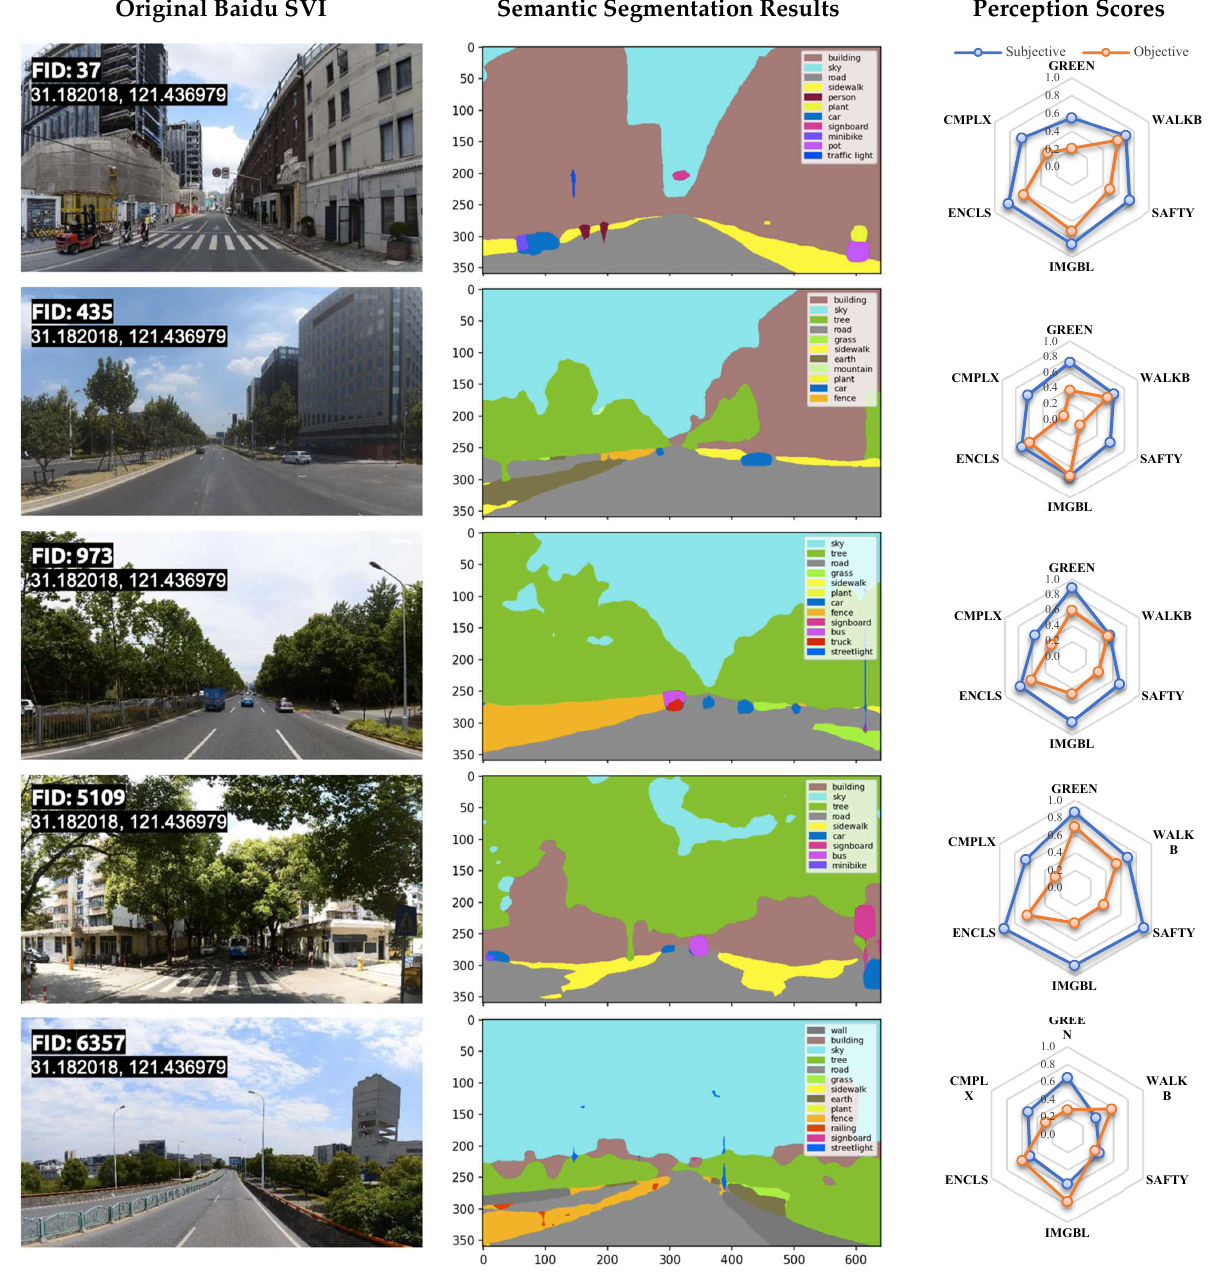
Figure 10. Samples of origin SVIs, semantic segmentation results, and the corresponding predicted subjective and derived objective perception scores.